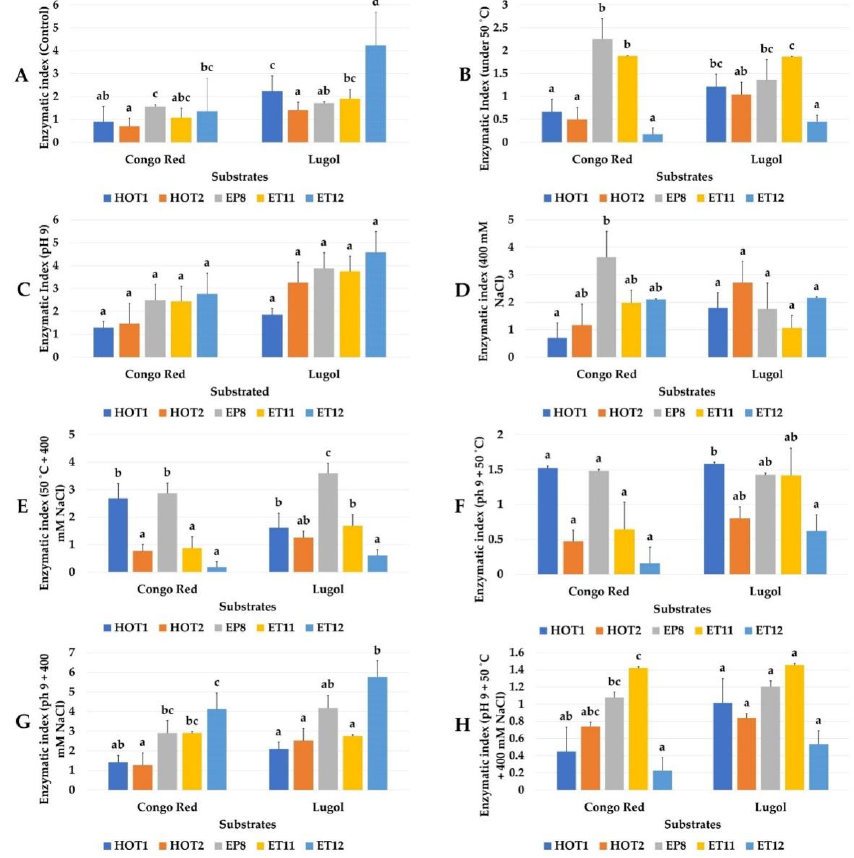
Figure 15. Effect of multiple stress on cellulase production on solid medium. The results are expressed as the mean-standard error of the values of the enzymatic indexes in duplicate. The effects of the revelators corresponding to each treatment and not sharing the same letters are significantly different according to Tukey’s post hoc HSD test.